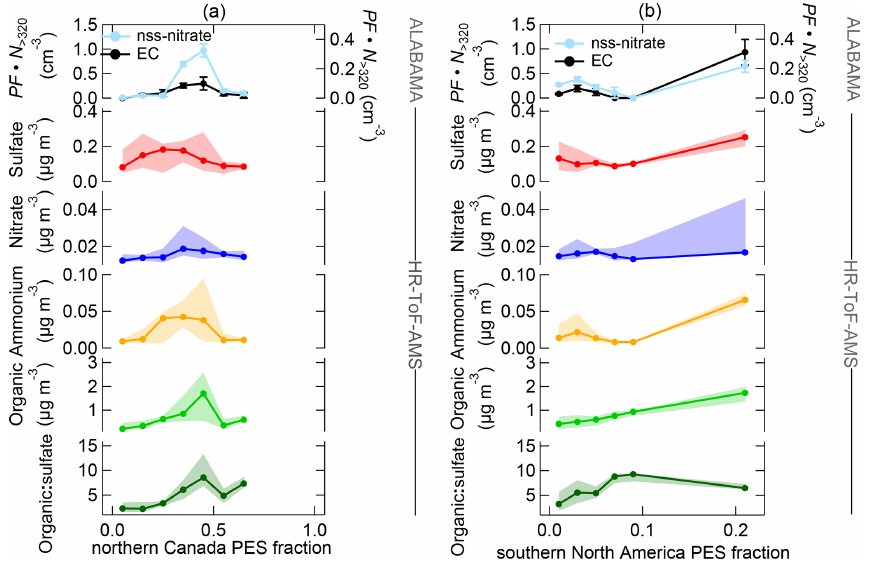
Figure 18. Aerosol composition measured by the ALABAMA and by the HR-ToF-AMS (indicated on the right side) as a function of FLEXPART-derived PES fraction over northern Canada (a) and southern North America (b) during the southern air mass period. The top panel represents the scaled ALABAMA number concentration (PF · N > 320 ) with the right axis referring to EC-containing particles (black) and left axis referring to nss-nitrate-containing particles (light blue). Lower panels represent each median (solid line with marker) and interquartile range (shaded area) of the HR-ToF-AMS mass concentrations of sulfate (red), nitrate (blue), ammonium (orange), organic matter (light green), and the organic-to-sulfate ratio (dark green). Uncertainty analyses are given in Sect. S7.